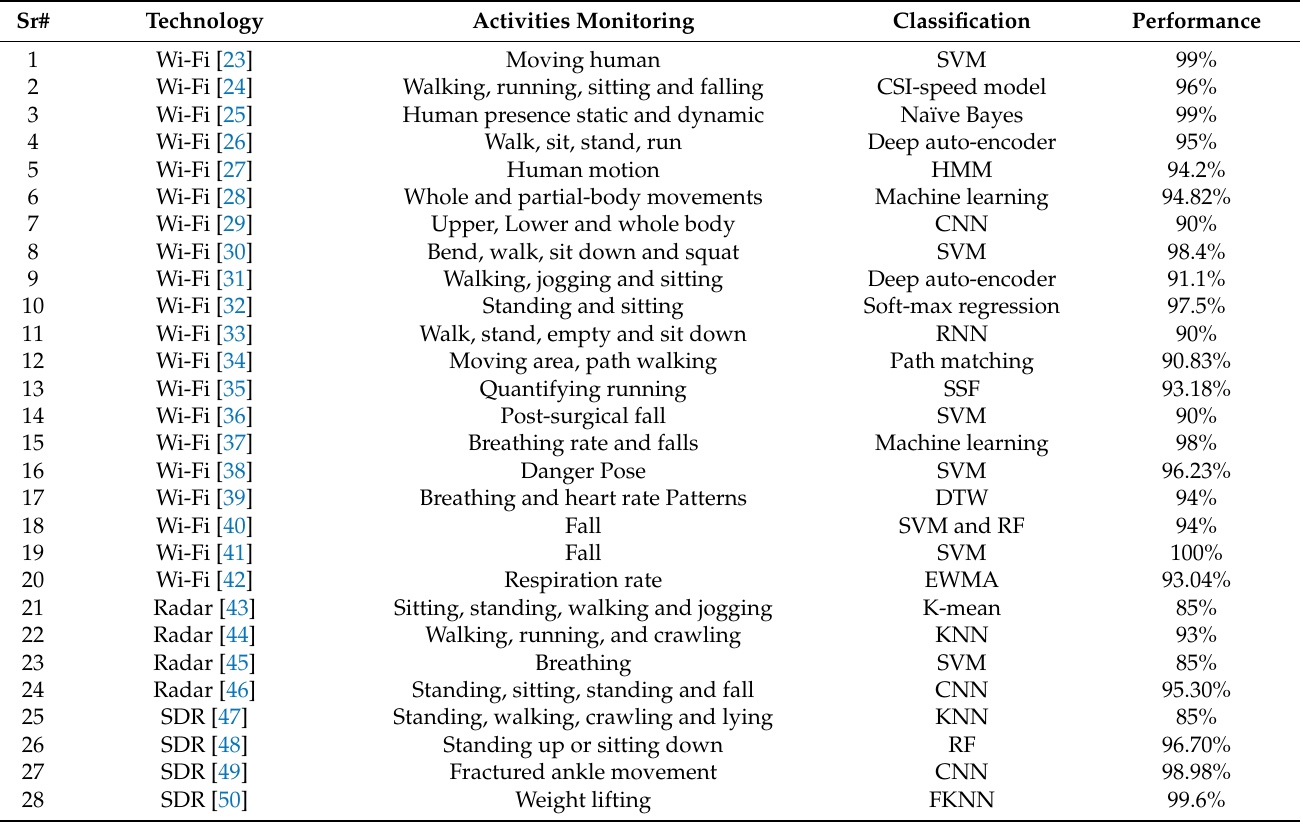
Table 1. Summary of non-contact human activity sensing